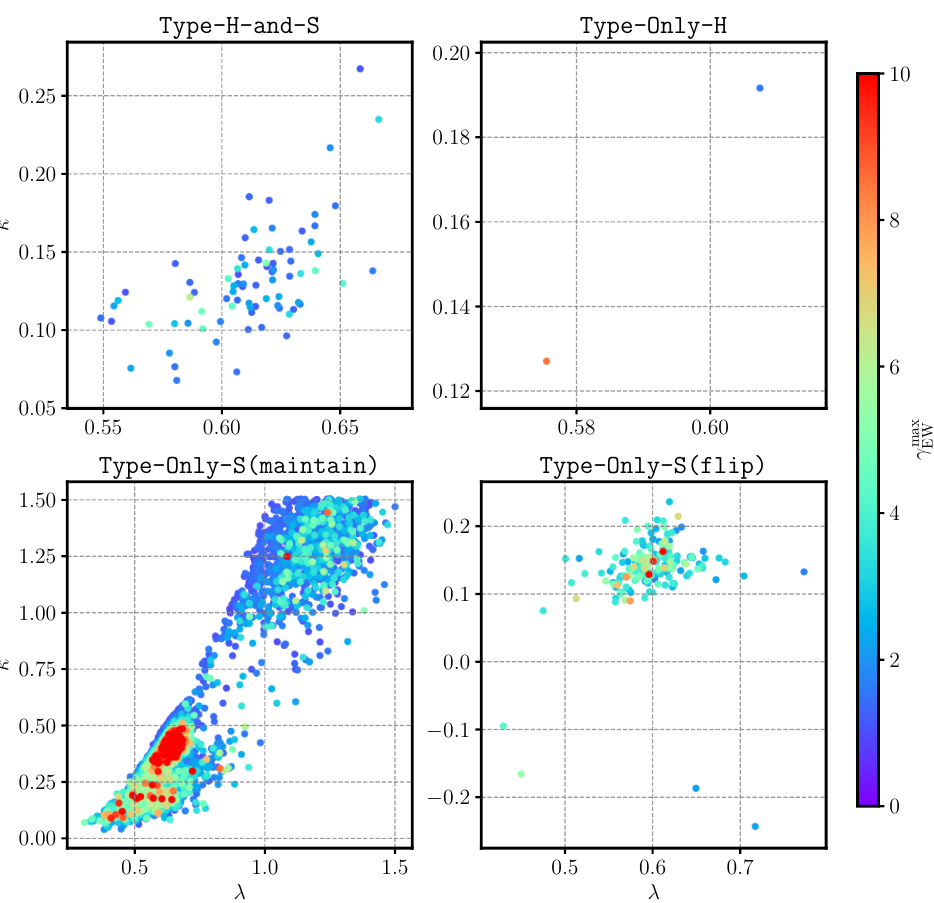
Figure 11 . ( (cid:21); (cid:20) ) for samples for which the strongest FOPT does not end in the SM vacuum. The points are colored by the (cid:13) EW of the strongest